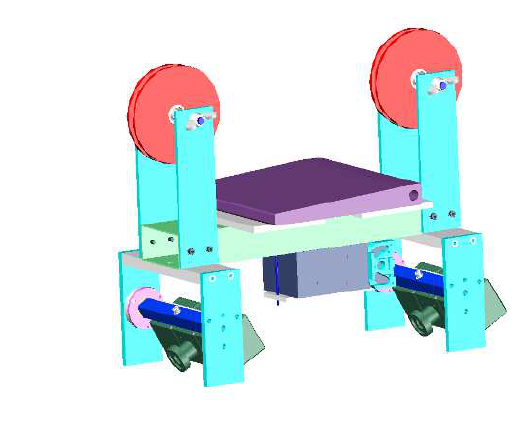
Figure 3. Visualized CAD model of the experimental device: sensor rack carrying two RIM sensors, capturing unit, and power supply.